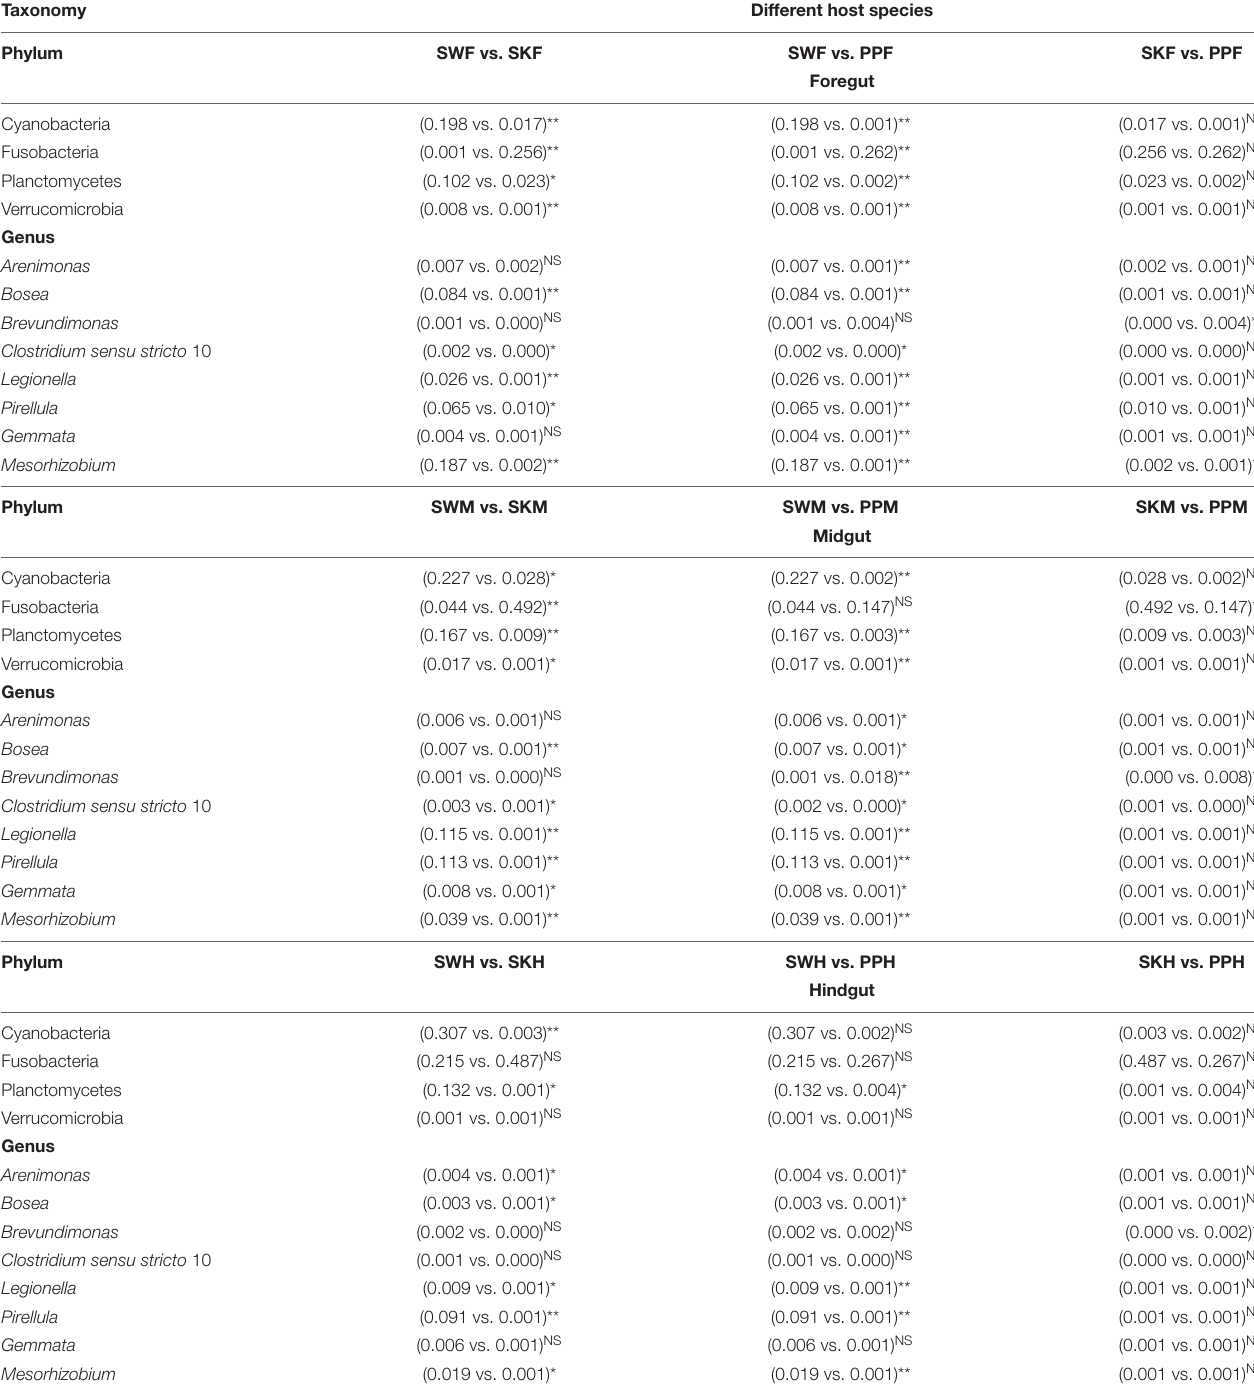
TABLE 1 | Comparison of the relative abundance of gut samples among different host species.